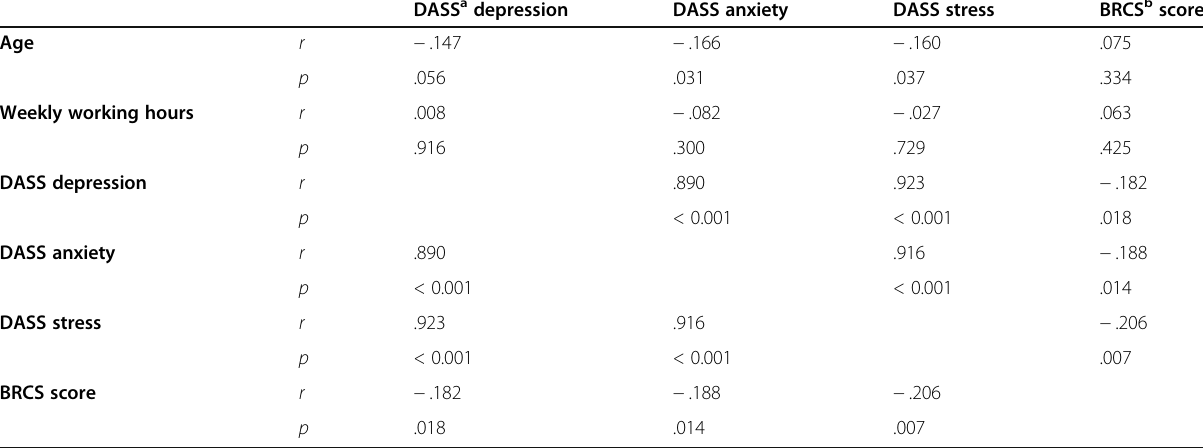
Table 5 Correlation between Depression, Anxiety and Stress Scales; Brief Resilient Coping Scale; and